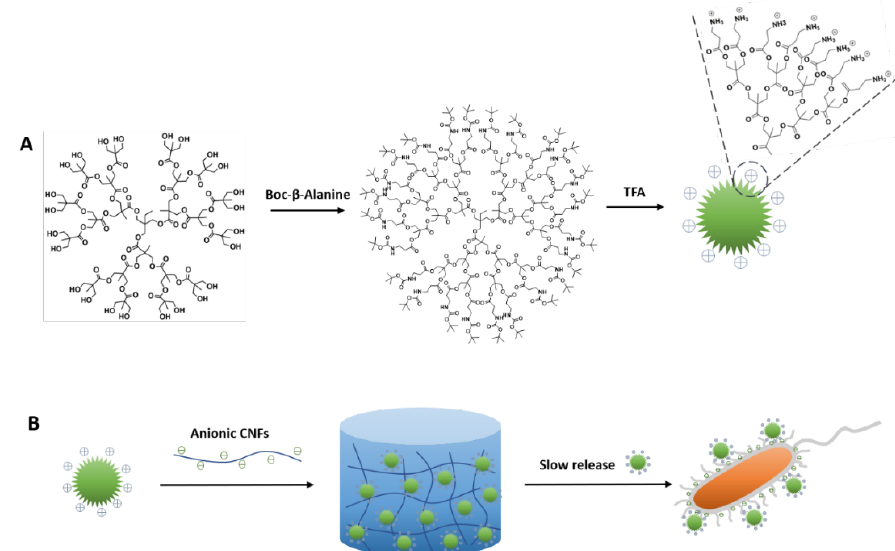
Scheme 1. Schematic diagram describing the synthesis of ( A ) boc- β -alanine functional dendrimers (G3) and the deprotection with trifluoroacetic acid (TFA). ( B ) Hybrid hydrogels based on the cationic